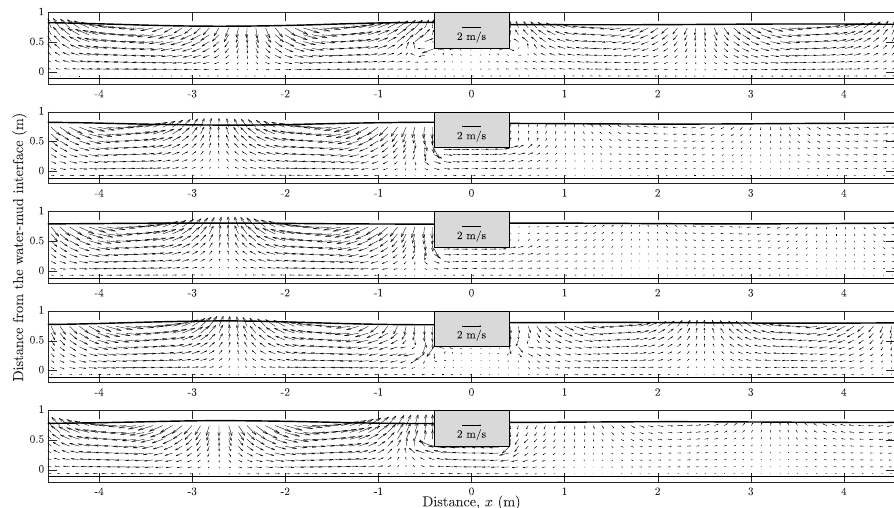
Figure 11. Snapshots of velocity field due to a surface obstacle on a muddy bed with d m = 3 δ m . Top to bottom: t / T = 1 model inputs.